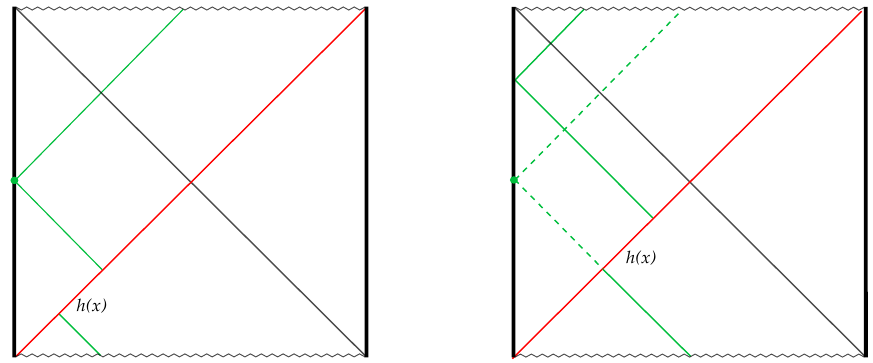
Figure 3 . Bulk representations of | ψ i and | ψ 0 i . For the state | ψ i (left), the shockwave (red) created by W is inserted first and the probe operator V is then inserted at t = 0 , manifesting itself as a particle (green) propagating into the future and the past. On its way to the past, it encounters the already existent shockwave and is shifted by an amount h ( x ) . On the other hand, | ψ 0 i (right) is created by inserting V first and then placing the shockwave W . The shockwave alters the original trajectory of the V particle, such that it is shifted to the future of the